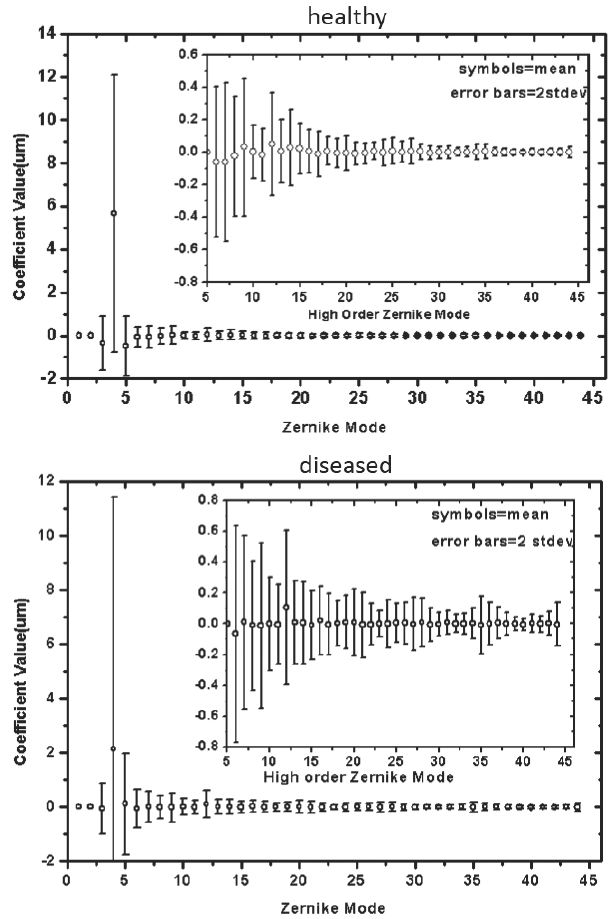
Fig. 1. Mean values of Zernike coe±cients from the 2nd to the 8th order in the normal group and abnormal group across a 6.0-mm pupil. The error bars represent plus and minus one standard deviation from the mean